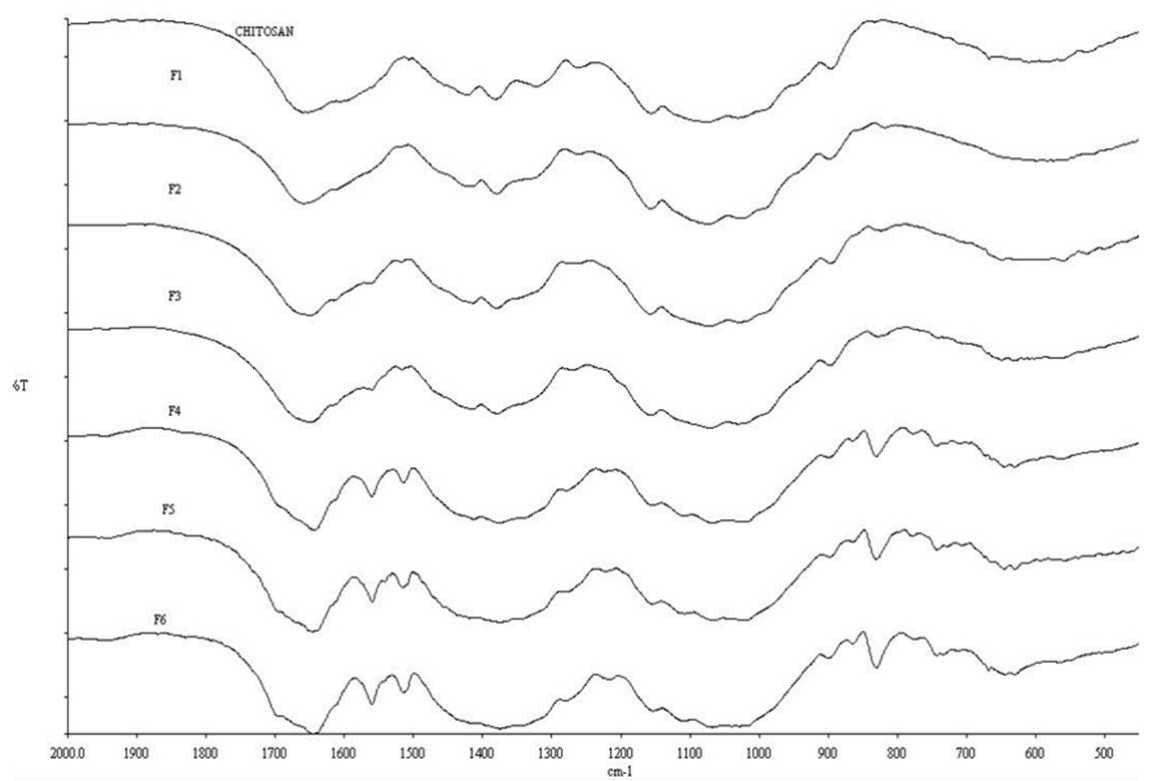
Figure 1. FTIR spectra of chitosan and conjugates F1 through F6 (as a function of increased PBA